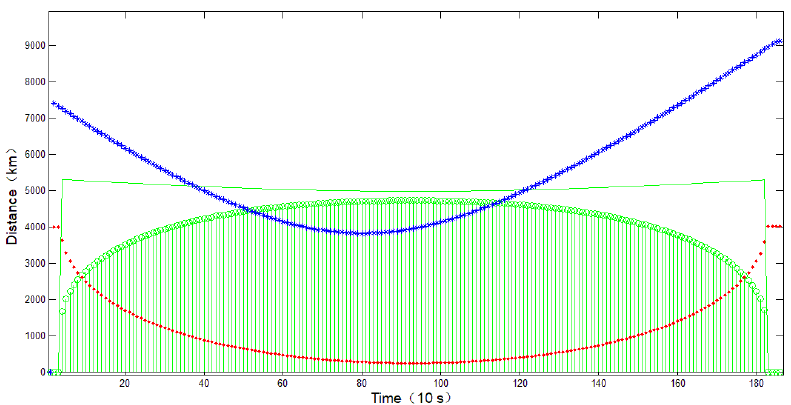
Figure 9. Time sequence of detection area variation.